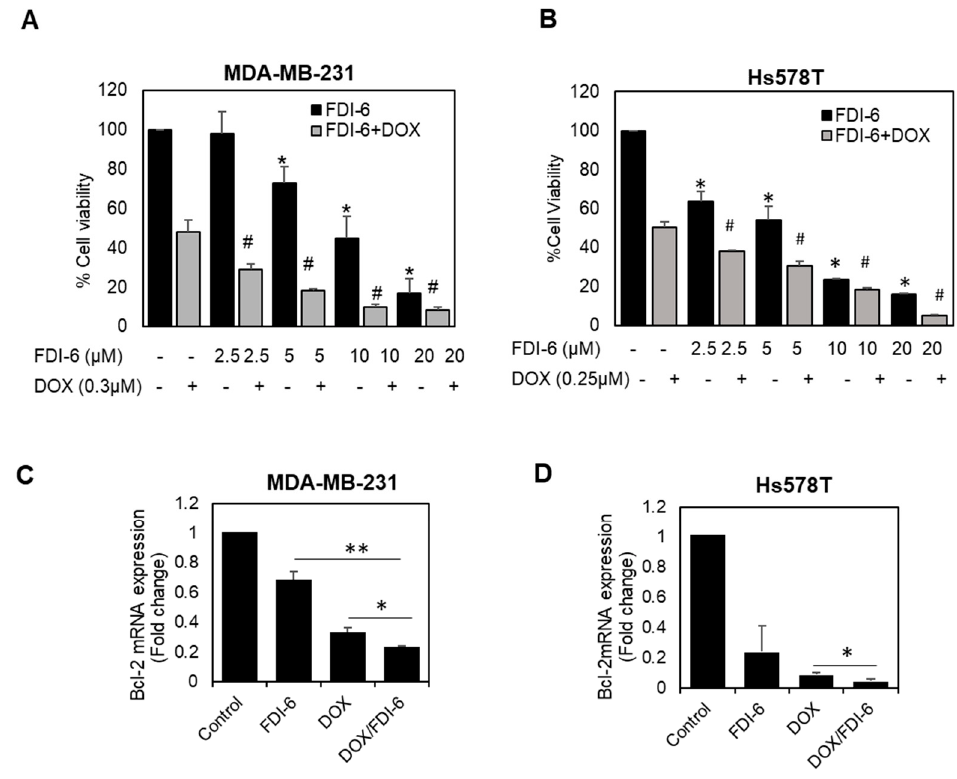
Figure 8. Synergistic effect of the combination of FDI-6 and doxorubicin. ( A , B ) The cytotoxic effects using SRB assay of ( A ) MDA-MB-231 and ( B ) Hs578T cells treated with different combination of FDI-6 and doxorubicin; ( C , D ) The relative Bcl-2 mRNA expression level of the treated ( C ) MDA-MB-231 and ( D ) Hs578T cells with an IC50 concentration of DOX, FDI-6, and DOX/FDI-6 combination. The bar graphs represent the average of three independent experiments ± S.D. ( n = 3). Data analysis was performed using one-way ANOVA. A p -value < 0.05 was considered significantly different and denoted as follows: * p < 0.05 and ** p < 0.01 representing significance compared with control, # p < 0.05 representing significance compared with DOX alone.